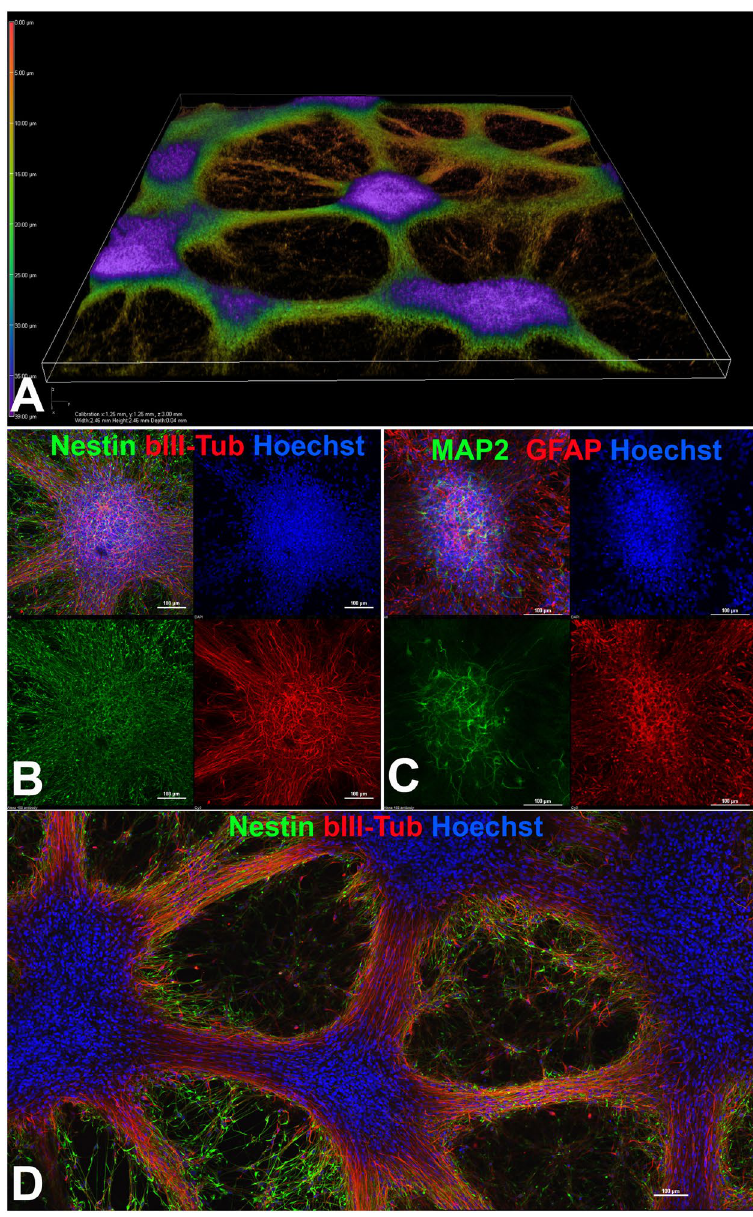
Figure 2. drNPC cultured in the PRP based liquid matrix. ( A ) 3D reconstruction of cultured drNPCs-01 in PRP based hydrogel using laser scanning confocal microscopy. ( B ) Spontaneous differentiation of neural organoids formed in PRP based hydrogel with the appearance of β III-tubulin neuronal progenitors (red) amongst the more common Nestin positive (green) NPCs ( C ) Neural organoids stained with MAP2 (green) and GFAP (red) further confirming glial and neuronal differentiation. ( D ) Low magnification image showing the overall morphology of the differentiating cultures with large numbers of Nestin positive (green) NPCs and β III-tubulin positive neurons (red). The optical plane cuts through the center of the neural organoids. ( B–D ) bar = 100 µ